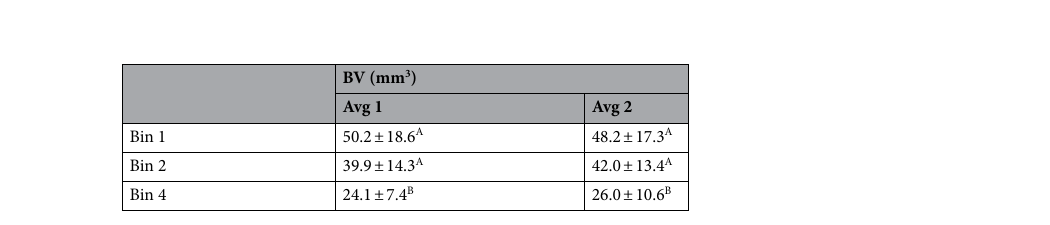
Table 2. Mean and standard deviation of BV values, according to frame averaging (Avg 1 or Avg 2) and data binning (Bin 1, Bin2, and Bin 4). Different uppercase letters among the rows in a column indicate significant differences, Bonferroni post-hoc test (p < 0.05).